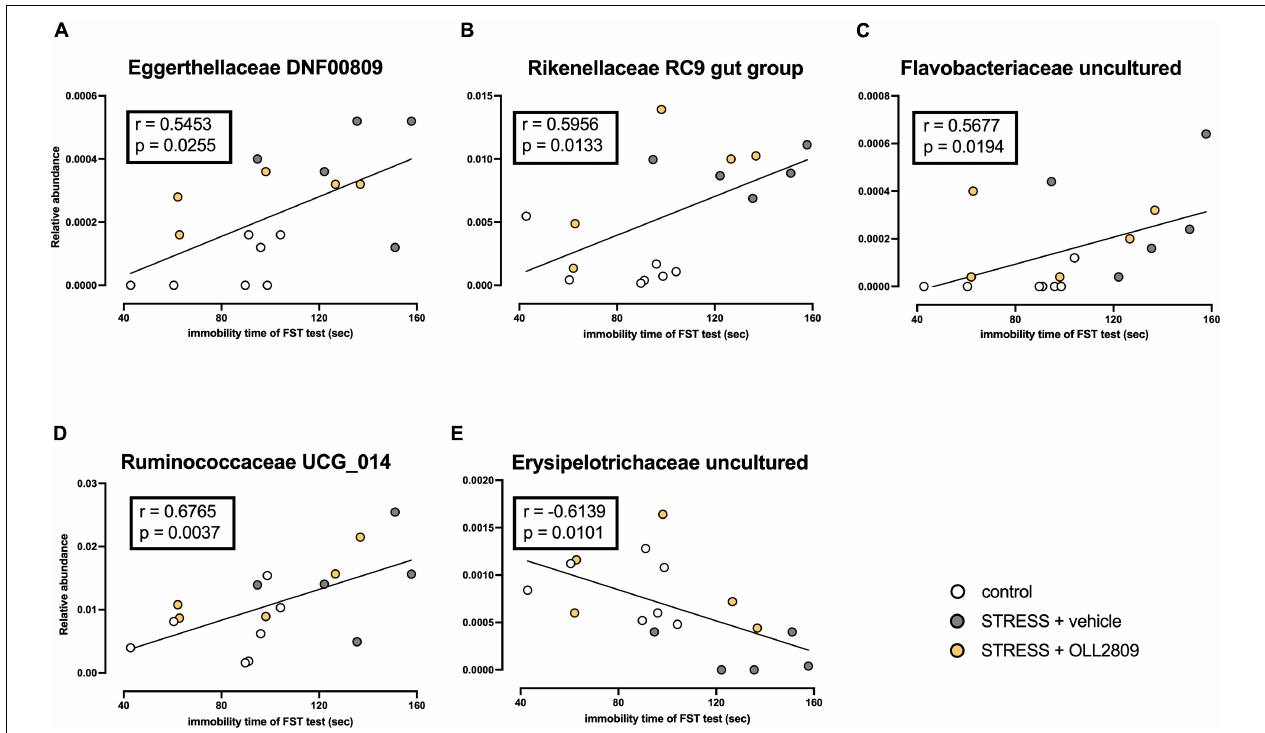
FIGURE 5 | Correlation between immobility time in the forced swim test and the gut microbial abundances for which significant changes were detected by LEfSe analysis. (A) Eggerthellaceae DNF00809, (B) Rikenellaceae RC9 gut group, (C) Flavobacteriaceae uncultured, (D) Ruminococcaceae UCG_014 and (E) Erysipelotrichaceae uncultured. The Spearman correlation analyses of R -values and p -values are shown in each box. Control, n = 7; stress + vehicle, n = 5; stress + OLL2809, n =